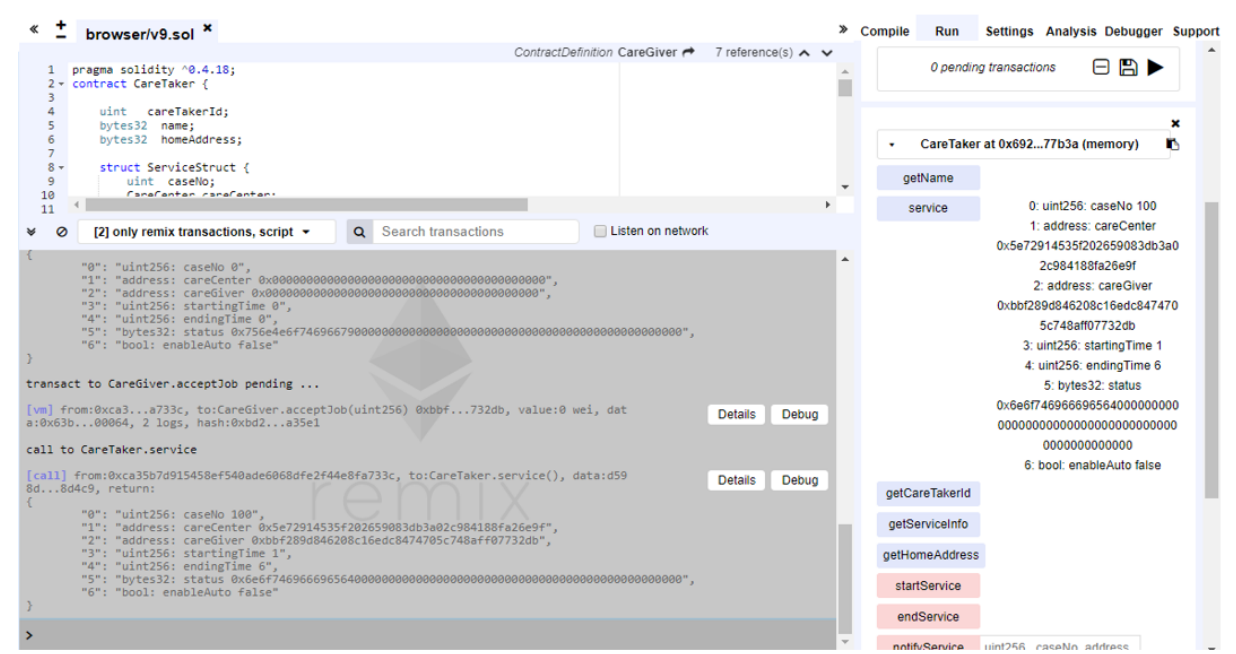
Figure 7. Illustration of the caretaker contract status after task assignment.